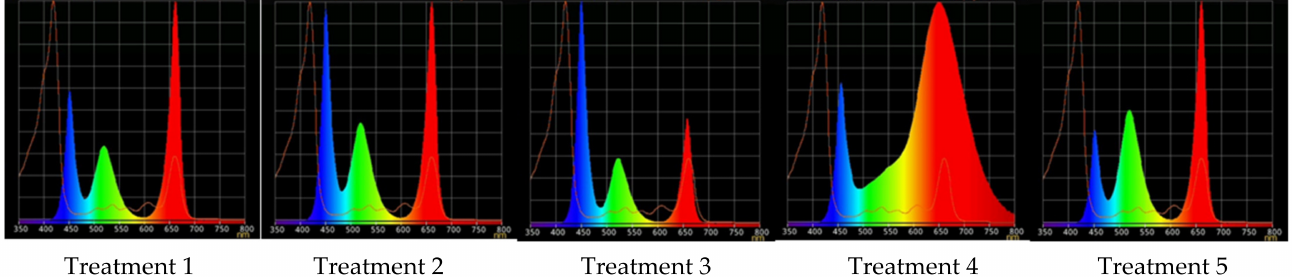
Figure 8. Light treatment spectra, red (R), green (G), and blue (B) light LEDs combinations: Treatment 1–3, 5—“blue” ( ∆ λ 0.5 = 435 ÷ 458 nm, λ max = 447 nm), “green” ( ∆ λ 0.5 = 500 ÷ 540 nm, λ max = 518 nm), “red” ( ∆ λ 0.5 = 645 ÷ 666 nm, λ max = 656 nm); Treatment 4 (control)—“white” (COB, T color =